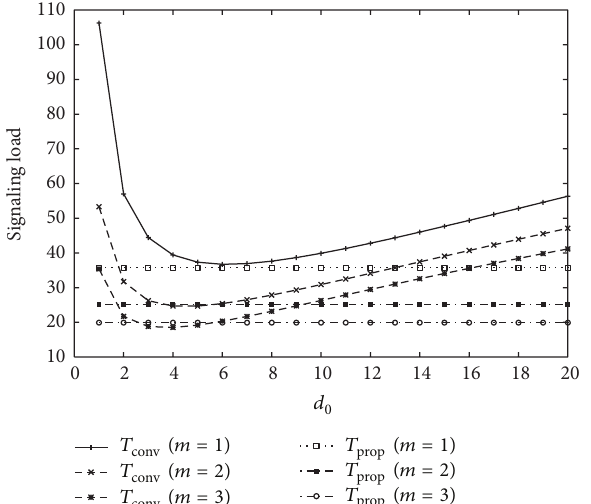
Figure 7: Effect of cell residence time variance on signaling load ( 1/𝜆 𝑐 = 10.5∗2/3600(ℎ) (high mobility), 1/𝜆 = 10.5∗100/3600(ℎ) (short intersession idle